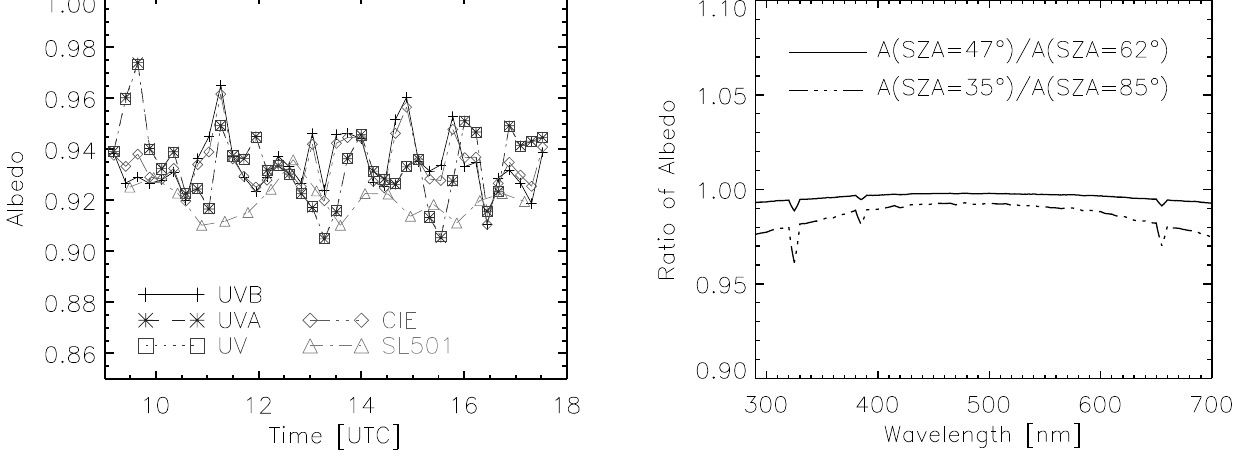
Fig. 8. Diurnal cycle of different integral albedo values measured on 2 January 2004. The sky was covered by stratiform clouds. A dependence of albedo on time (thus SZA) cannot be observed for this day.